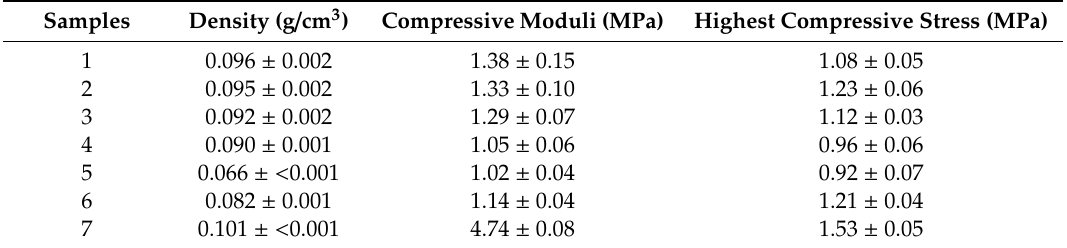
Table2. CompressivemechanicalpropertiesofPAfoams,